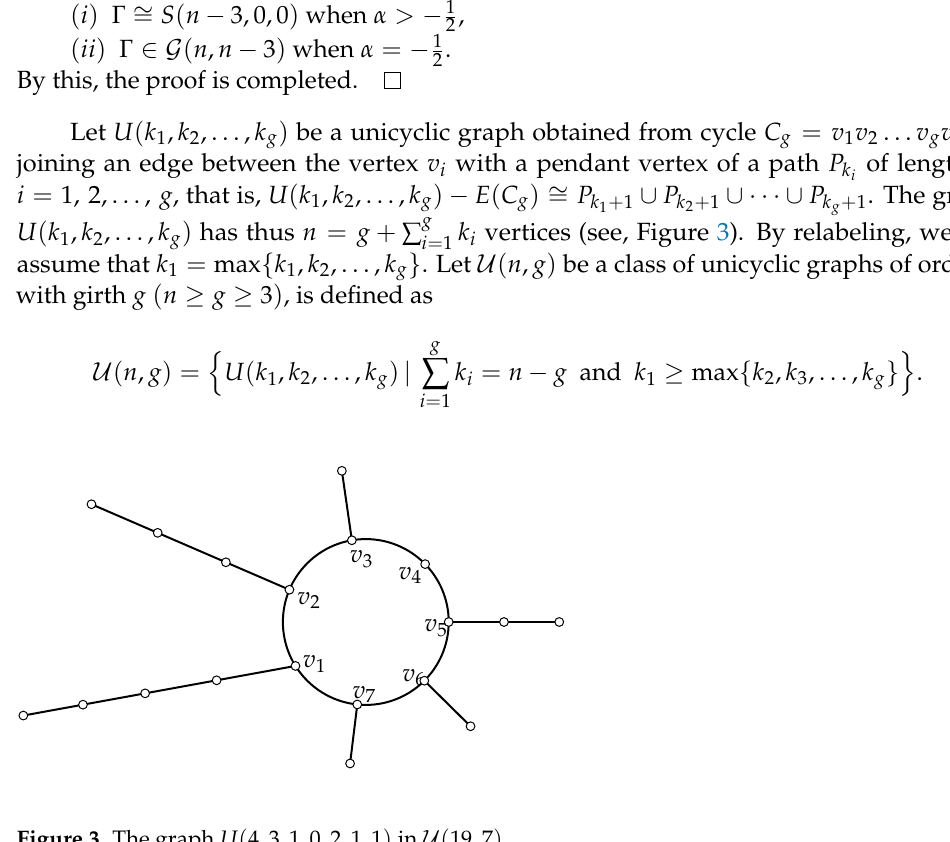
Figure 3. The graph U ( 4,3,1,0,2,1,1 ) in U ( 19,7 ) .